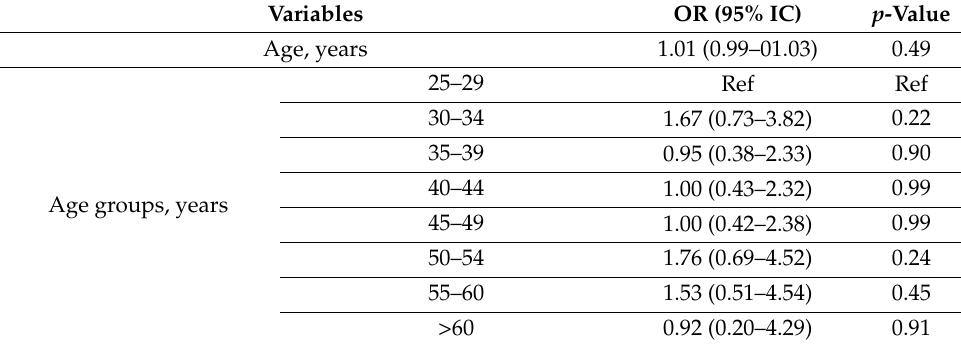
Table 3. Logistic regression analysis to assess the relationship between demographic, epidemiolog- ical and clinical variables and severity of diseases (CIN2+) at baseline.